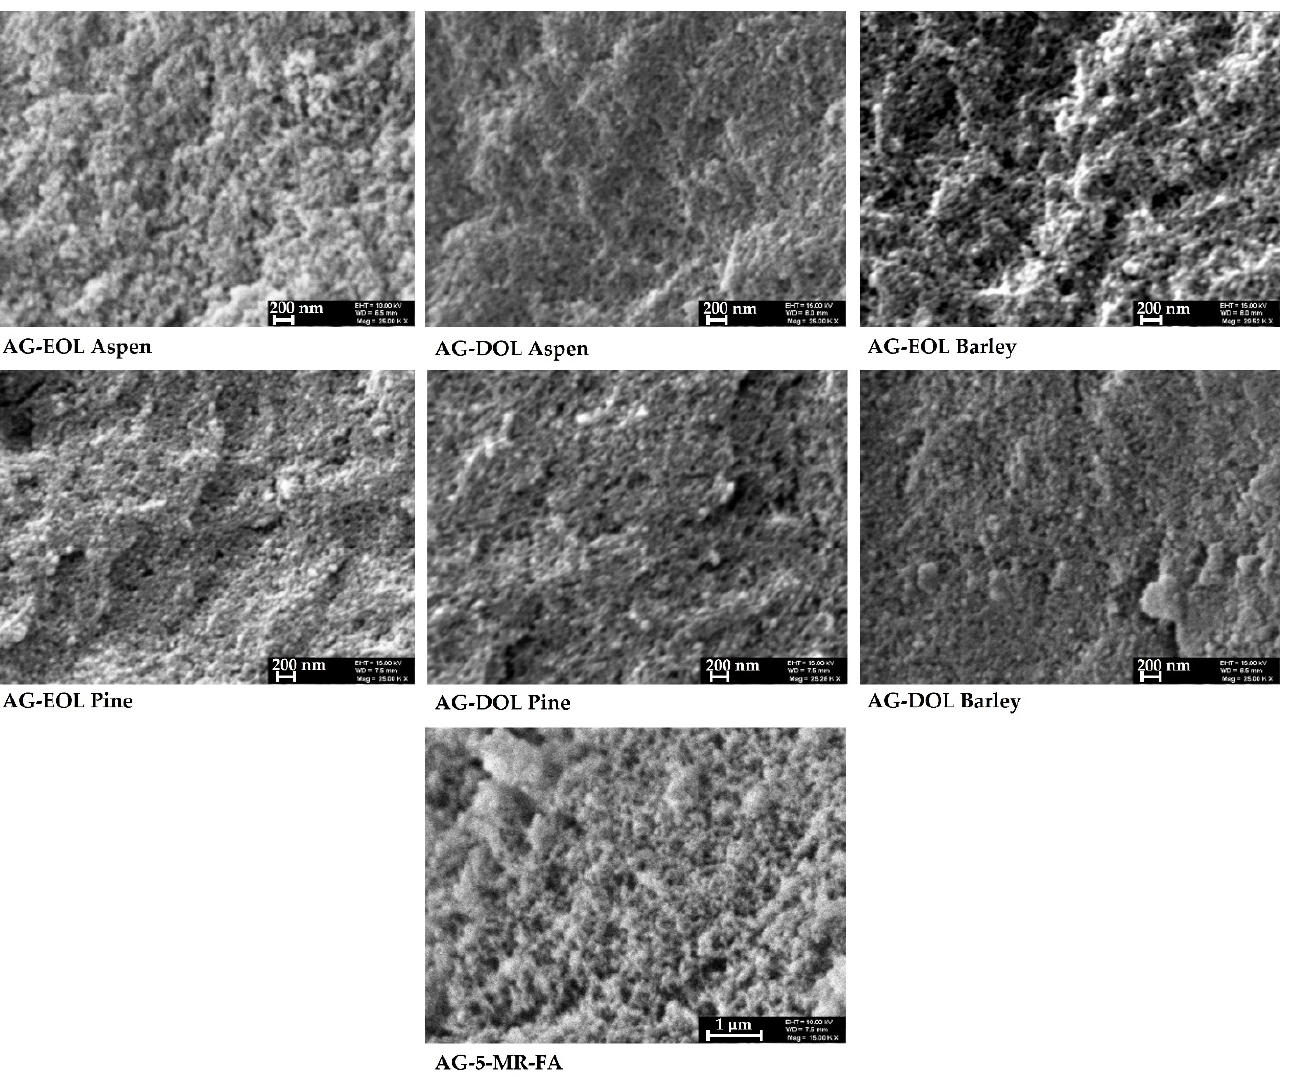
Figure 8. Examples of the SEM images of lignin-based (75% of the 5-MR was replaced by lignin) and 5-MR-FA aerogels.